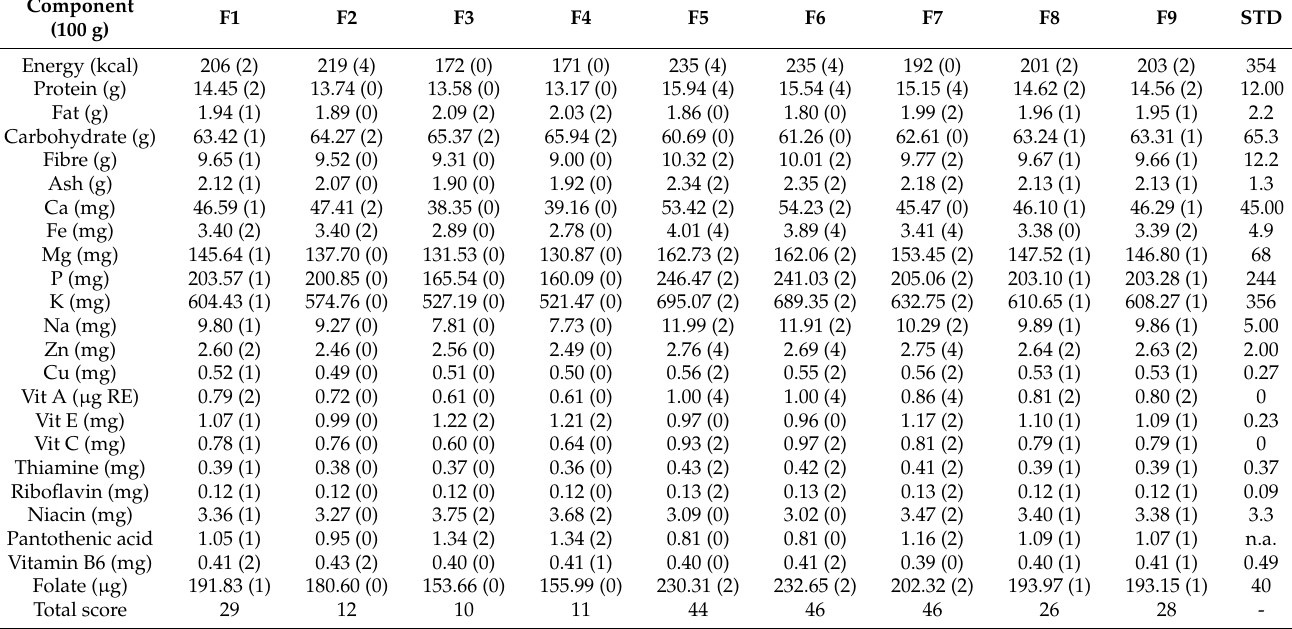
The estimated proximate composition of the flatbread formulations is presented in Table 3. An initial evaluation of the formulations was provided with scores (0, 1 or 2) based on the theoretical intake provided for each nutrient when compared with the range of variation within the experimental set. Based on this attribution, formulations F5, F6, and F7 exhibited the highest score for the energy and macronutrients (8) and micronutrients (26, 28, and 30, respectively) contents. Overall, F7 was evaluated as the formulation with the best theoretical nutritional profile (total score = 38), followed by F6 (total score = 36) and F5 (total score = 34). Table 3. Estimated macro and micronutrient composition of flatbread formulations (F1-F9) and of a 100% W flatbread (STD), per 100 g of flour. In brackets, the score attributed to the theoretical intake of each nutrient provided by the formulation is presented. The total score is the sum of the partial